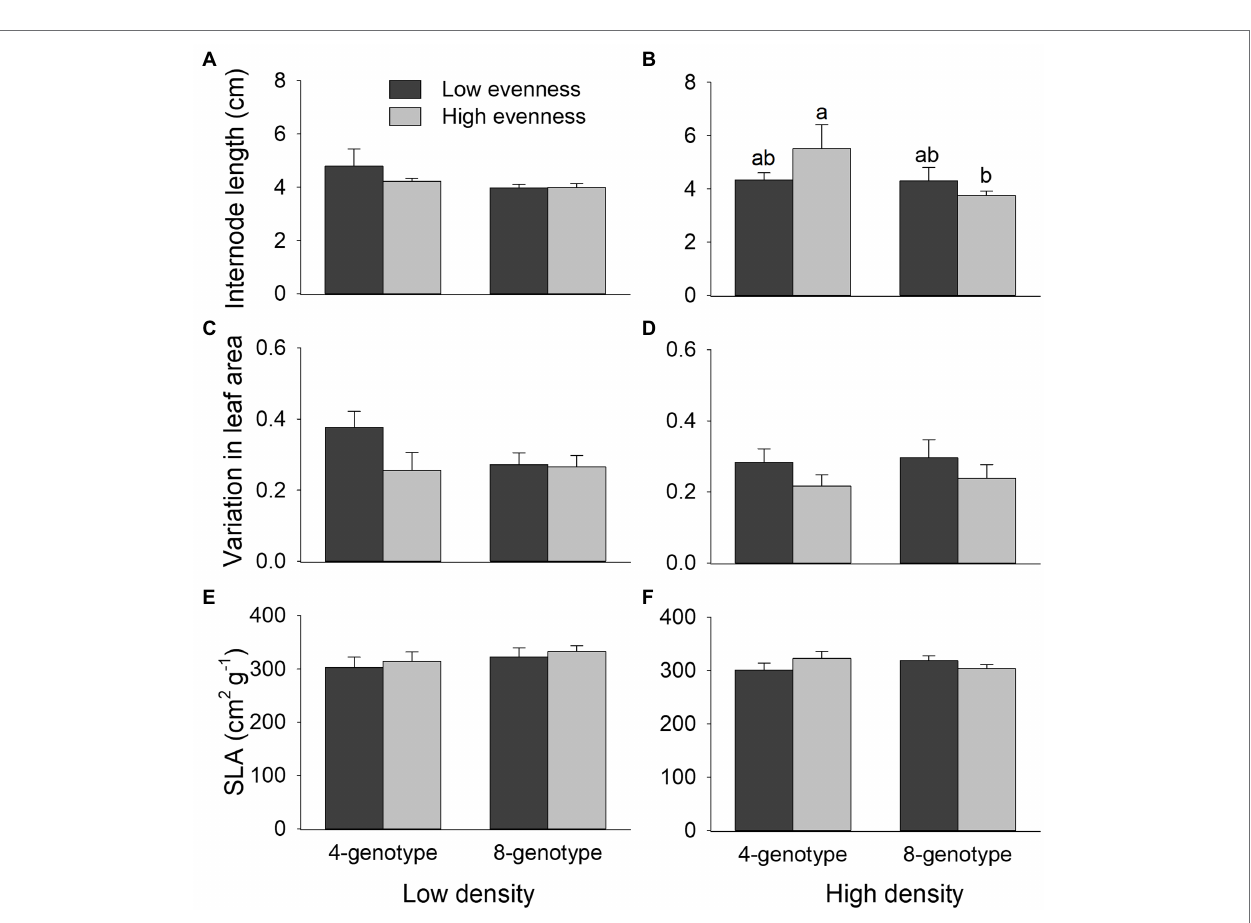
urgently needed to detect the relative importance of genotypic